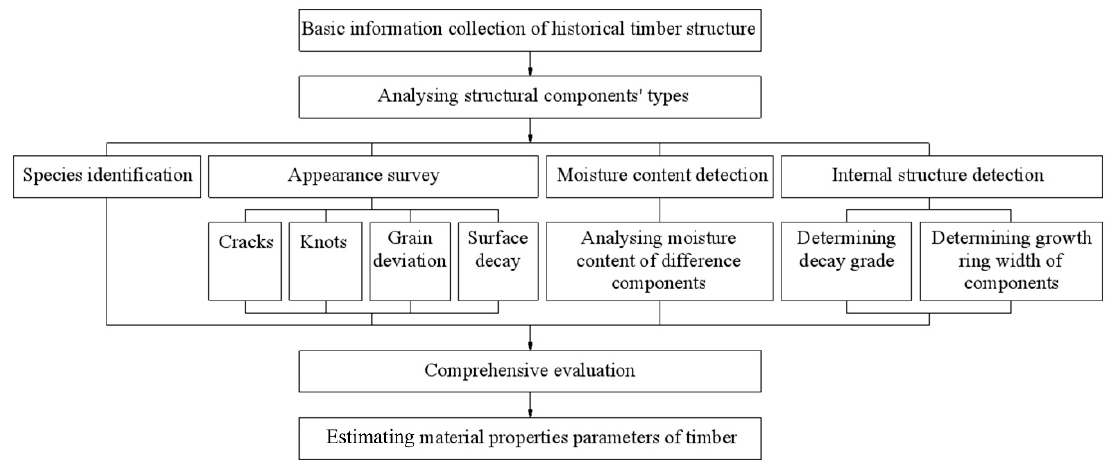
Figure 3. Flowchart of comprehensive evaluation of historical timber structural building.